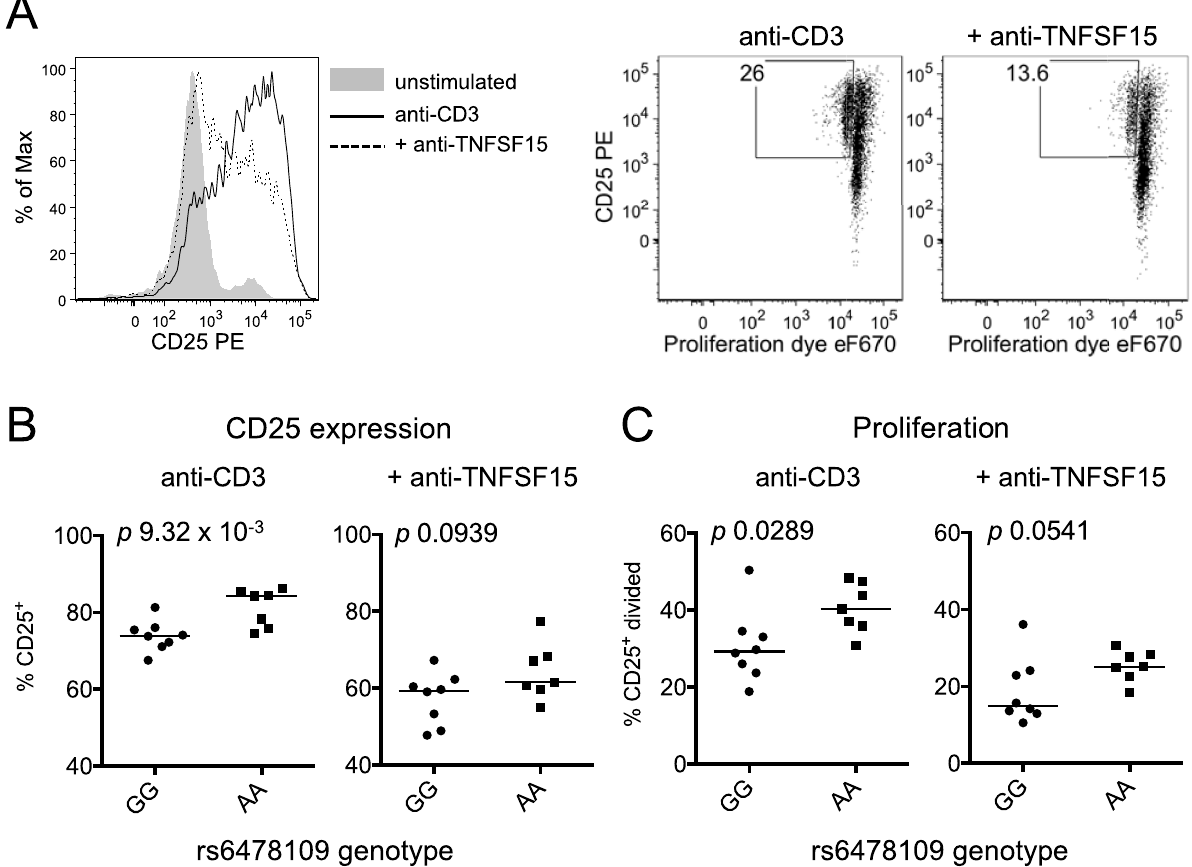
Fig 5. Genetically regulated TNFSF15 controls costimulatory capacity. ( A ) CD8-depleted PBMC were stained with proliferation dye eFluor670 and stimulated with 1 μ g/mL anti-CD3 with and without 10 μ g/mL anti-TNFSF15 for 48 hours. Flow cytometry plots depict cells gated on live, CD4 + cells. ( B ) CD25 + cells were measured as in (A) in samples from rs6478109 genotyped individuals (GG, n = 8; AA, n = 7). ( C ) CD25 + divided cells were measured in the same samples as in (B). p values from Mann-Whitney test.